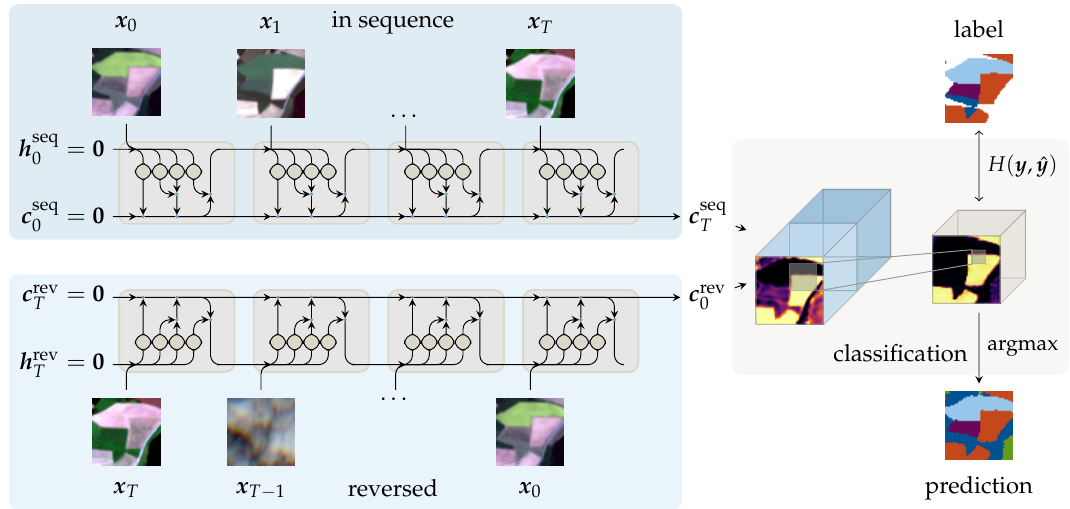
Figure 3. Schematic illustration of our proposed bidirectional sequential encoder network. The input sequence x of observations x t x 0 , . . . , x T ∈ { }